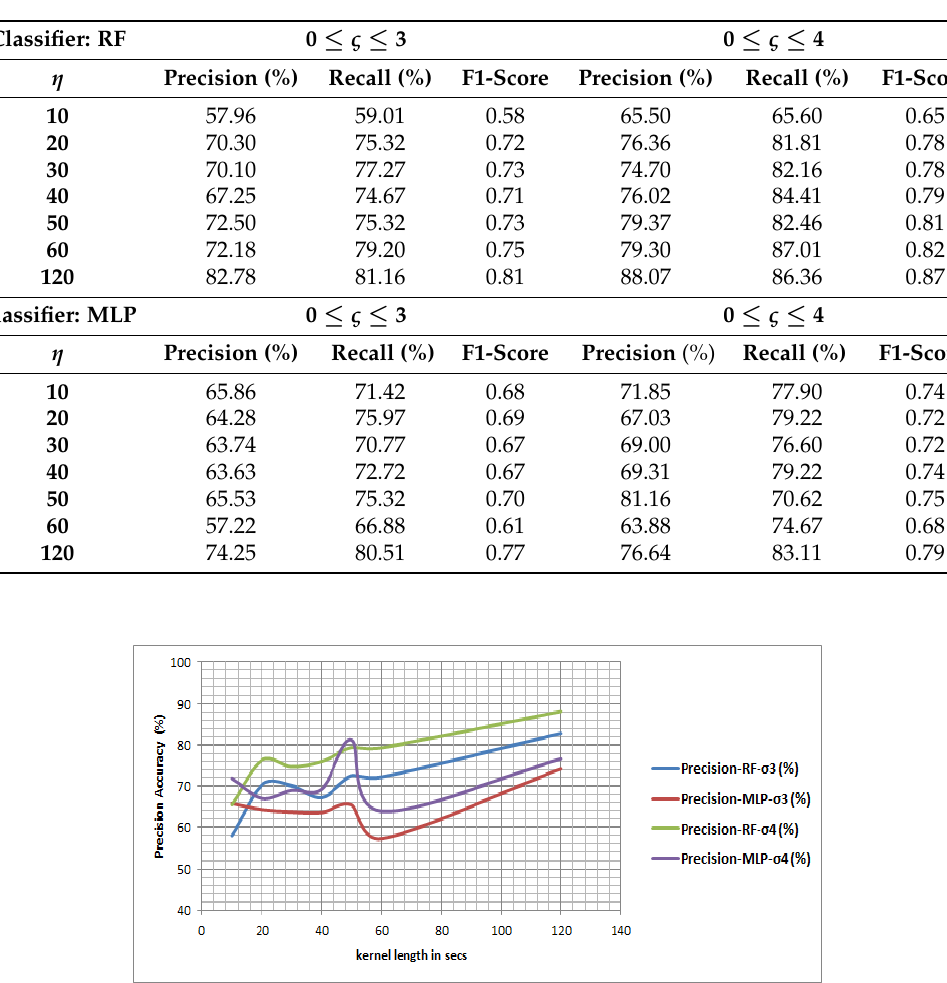
Table 8. Context 1, Scenario 1: Trip detection accuracy by RF and MLP based classifier using GPS, IMU and spatial information.